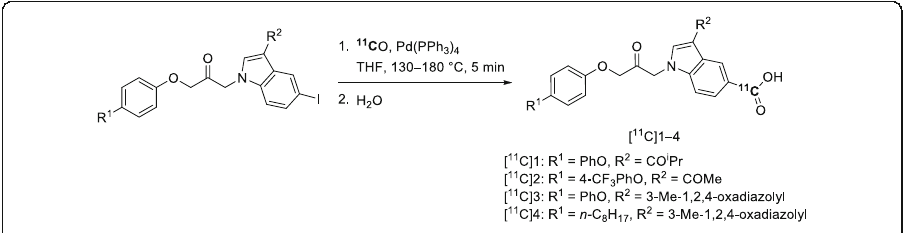
Fig. 31 11 C-Labeling approach used for four candidate inhibitors of cPLA2